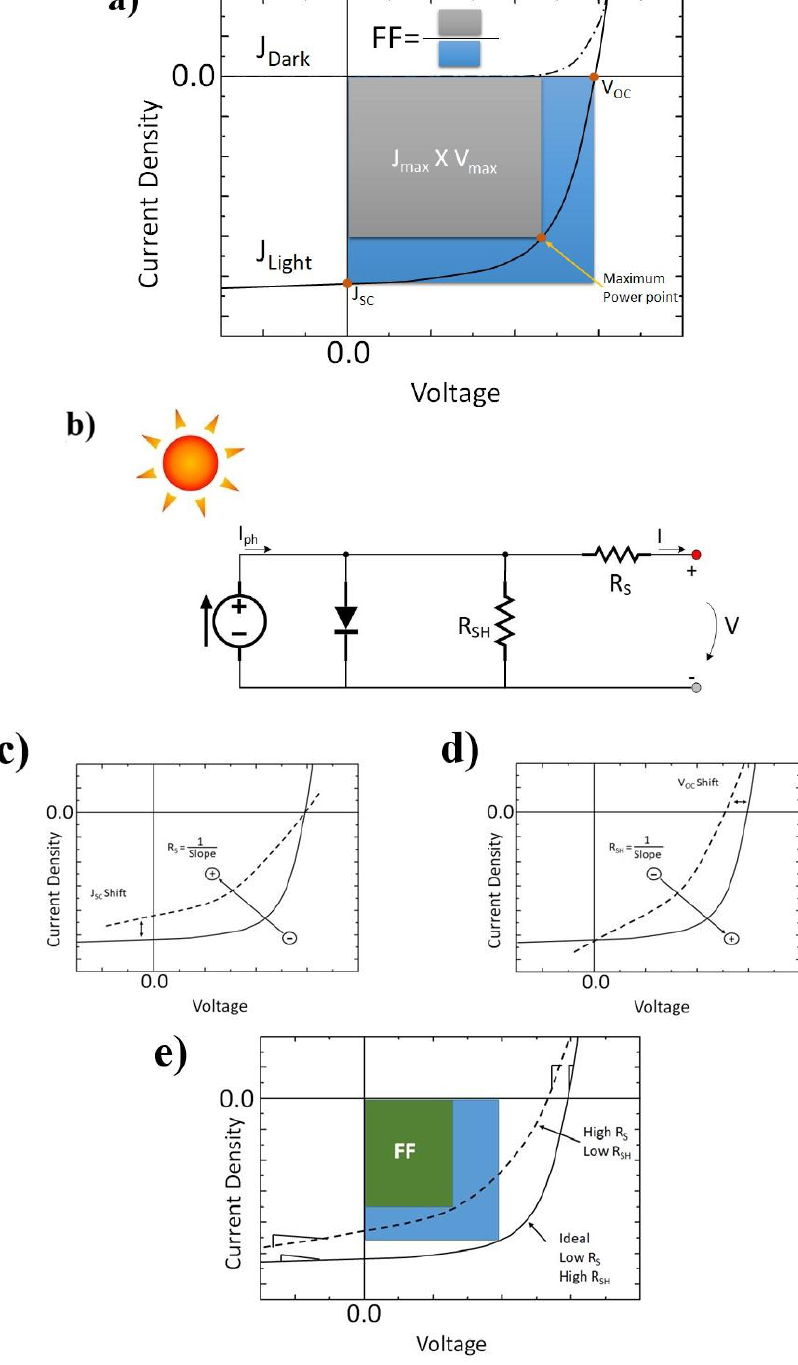
Figure 2. ( a ) Fundamental points in a solar cell I-V curve required for a full understanding of its figures of merit; ( b ) The usual OPV equivalent electrical circuit; ( c ) Impact of the variation of the series resistance ( R s ) on FF ; ( d ) Impact of the variation of the shunt resistance ( R sh ) on the FF ; ( e ) real I-V curve (as usually found) where both R s and R sh are not ideal.